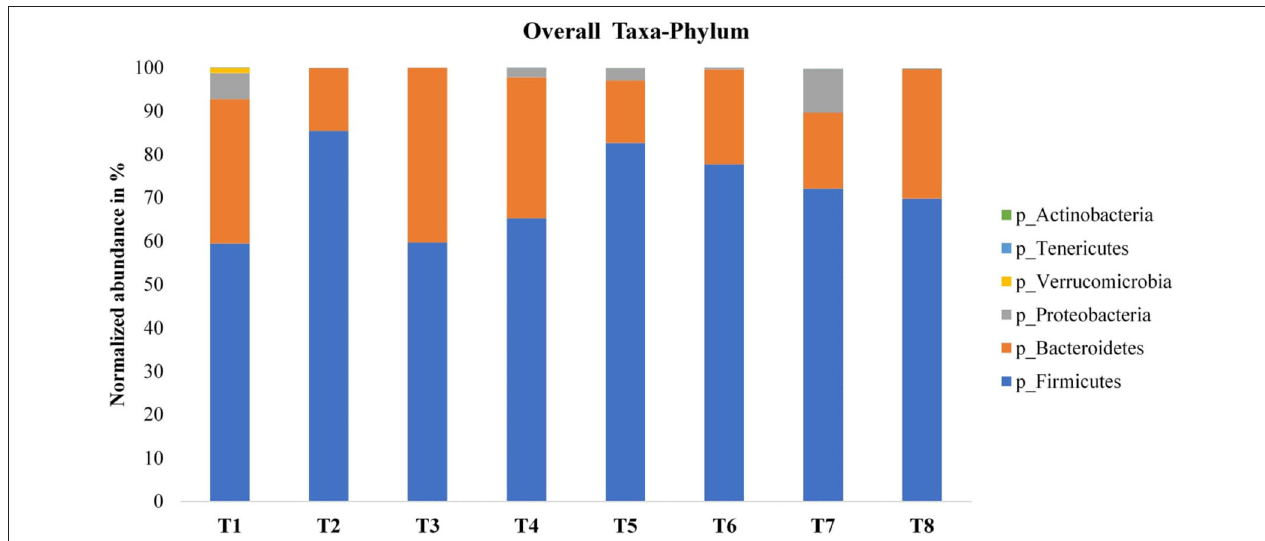
FIGURE 2 | Relative abundance in % of colon microbiota at the phylum level. T1 = Negative control (Basal diet), T2 = Positive control [Basalt diet + 0.01% (w/w) Oxytetracycline], T3 = Basal diet + 0.2% (v/w) postbiotic TL1, T4 = Basal diet + 0.2% (v/w) Postbiotic RS5, T5 = Basal diet + 0.2%(v/w) paraprobiotic RG11, T6 = Basal diet + 0.2% (v/w) postbiotic RI11, T7 = Basal diet + 0.2% (v/w) paraprobiotic RG14, T8 = Basal diet + 0.2% (v/w) paraprobiotic RI11. The most predominant phyla are Firmicutes (85.41%) in T2, Bacteroidetes (40.24%) in T3, Proteobacteria (10.03%) T7, Verrucomicrobia 1.21% T1, Tenericutes 0.11% in T8 and Actinobacteria 0.06% in